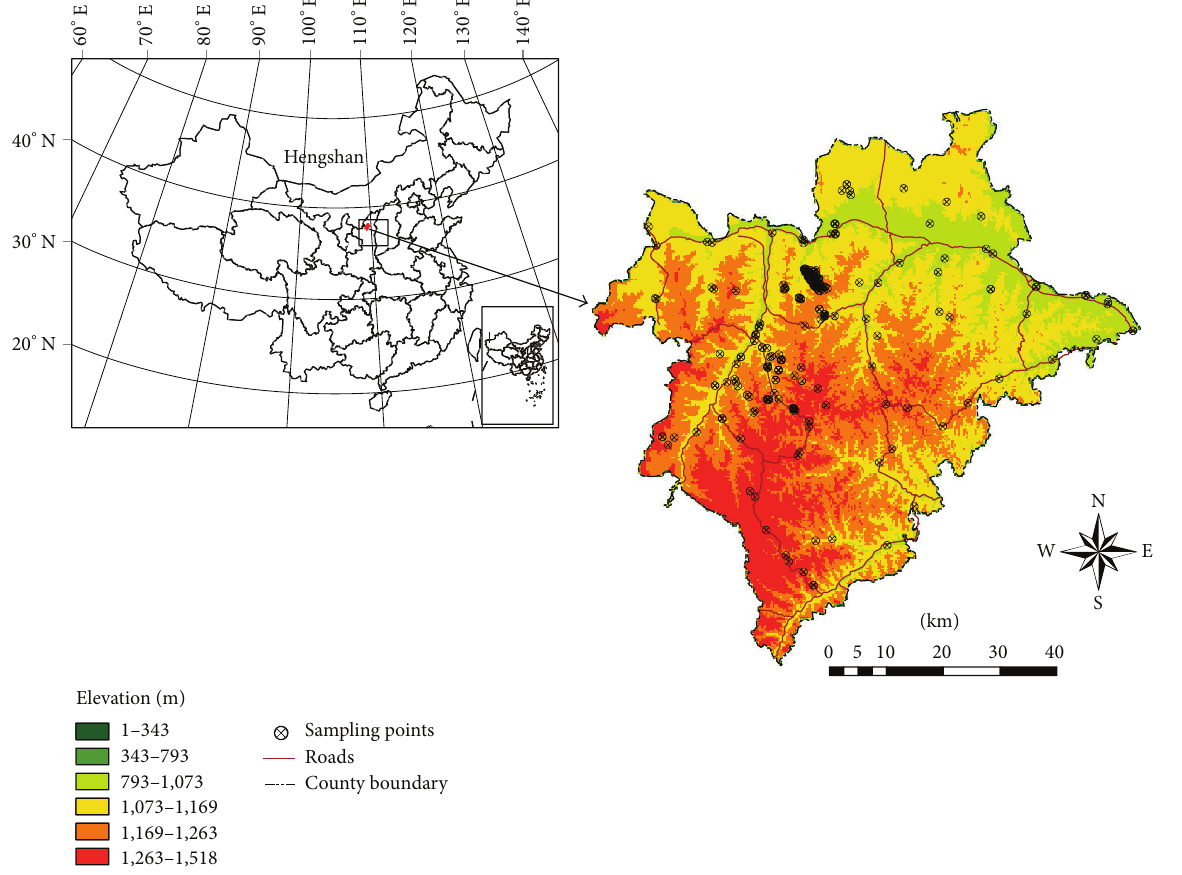
Figure 1: Location of Hengshan County.